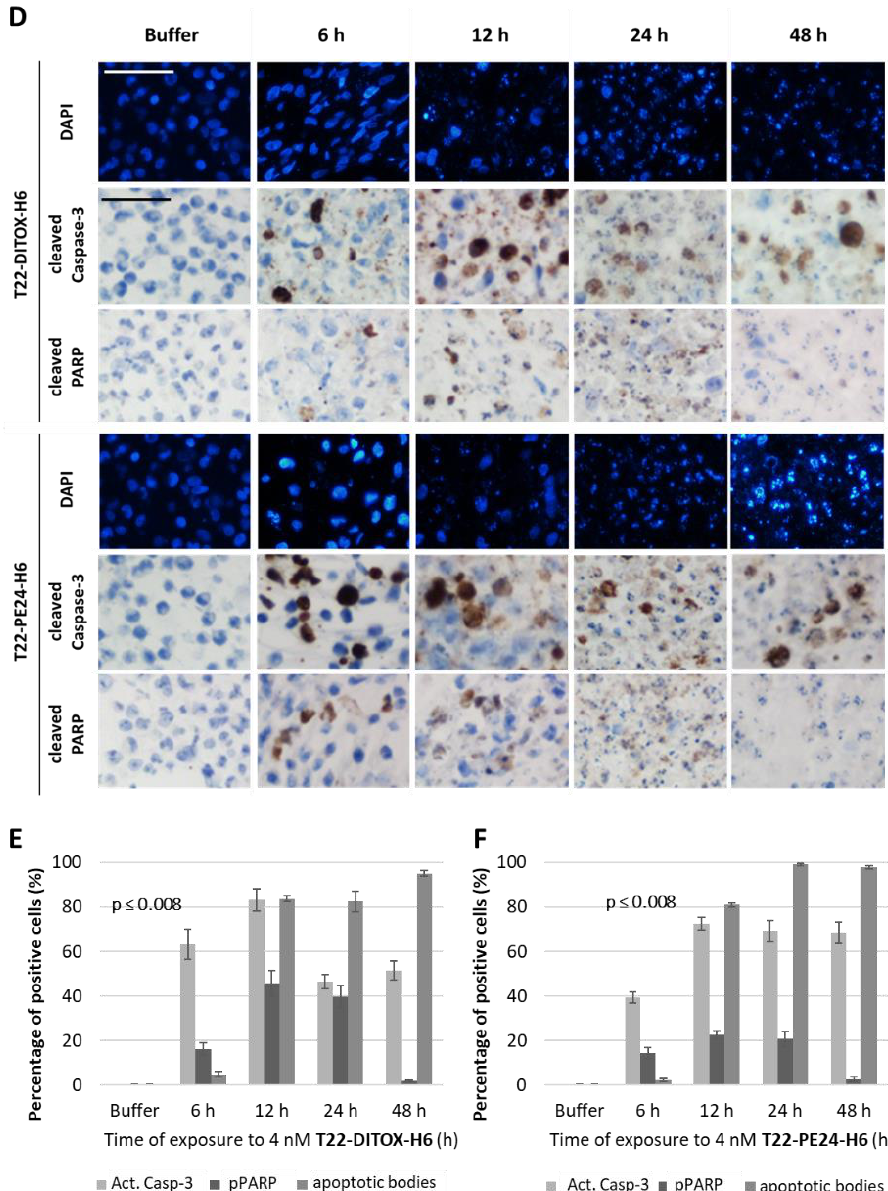
Figure 2. T22-DITOX-H6 and T22-PE24-H6-induced cell death in vitro in CXCR4 + AN3CA endome- trial cancer cells is mediated by apoptosis. ( A ) Representative dot-plot and quantitation of viable cells (green), at early (light blue) or late (navy blue) apoptosis using Annexin V-FITC/PI assay, after their exposure for 2, 6, 24 and 48 h to 4 nM of T22-DITOX-H6 ( B ) or T22-PE24-H6 ( C ), expressed as mean ± SEM. ( D ) Representative images of DAPI or immunohistochemistry staining of the apoptosis mediators, active cleaved caspase-3 and cleaved PARP. Experiments were performed using CXCR4 + AN3CA cell pellets after 6, 12, 24 or 48 h exposure to 4 nM of T22-DITOX-H6 or T22-PE24-H6. Bar: 50 µ m. ( E , F ) Quantification of positive cell percentage, compared to control, regarding the induction of apoptotic bodies (DAPI staining) and cleavage of caspase-3 (act. Casp-3) and PARP (pPARP) (Mann – Whitney; p < 0.008 in all cases).